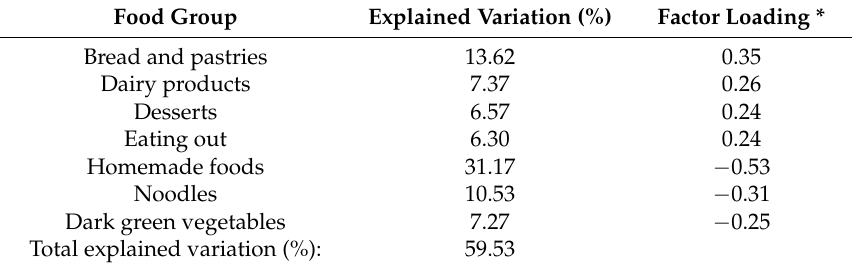
Table 3. Food groups that were strongly associated with the total testosterone-related dietary pattern scores identified by using a reduced rank regression (RRR).